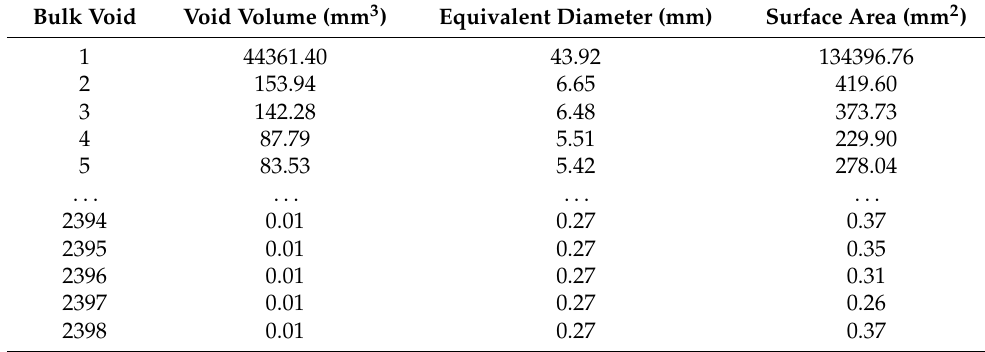
Table 7. Characteristic parameters of bulk voids in EPA-13 with 5.5% asphalt content.